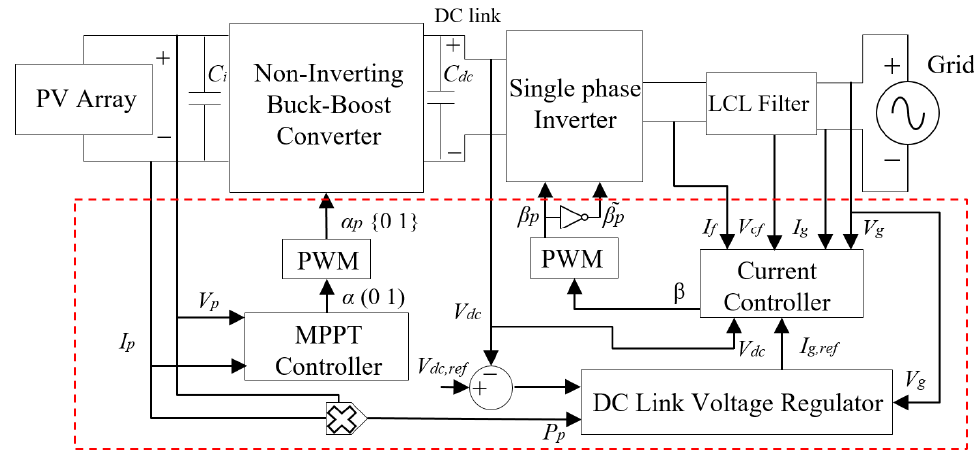
Figure 3. System schematics in detail.